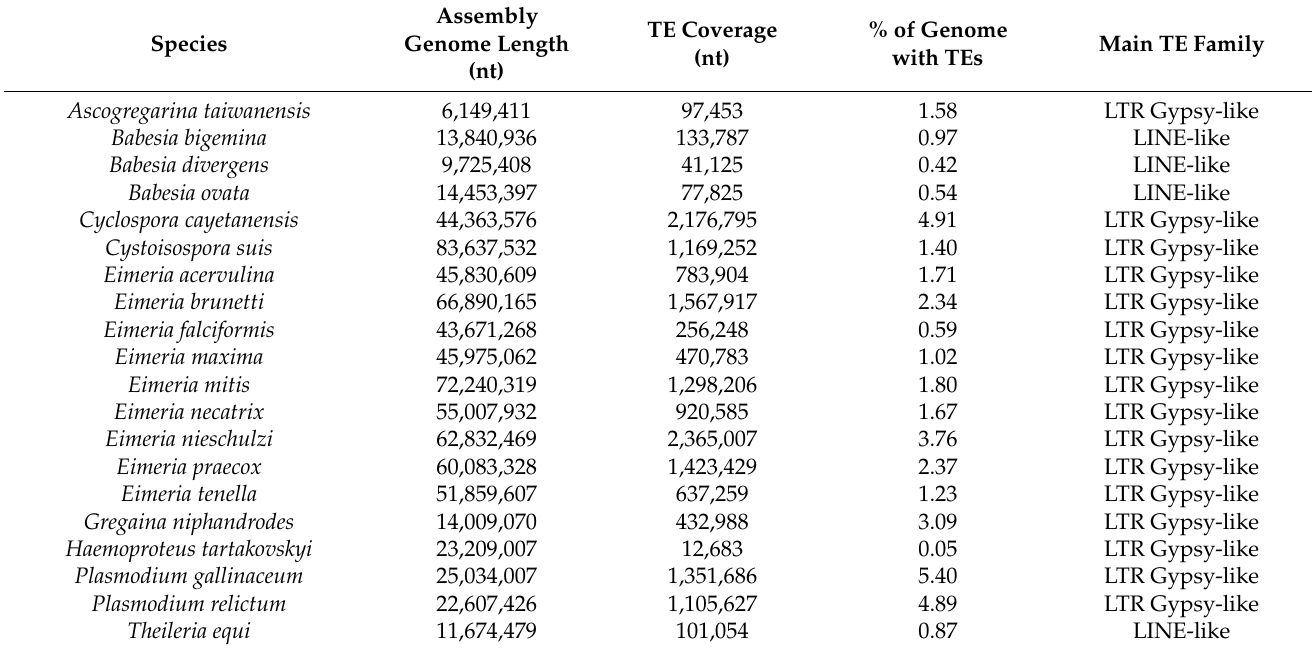
Table 2. Percent of the genome covered by our TE models and main family of TE observed after mapping our TE models against all apicomplexan genomes using RepeatMasker. From all sixty-four apicomplexans, we obtained hits to only twenty